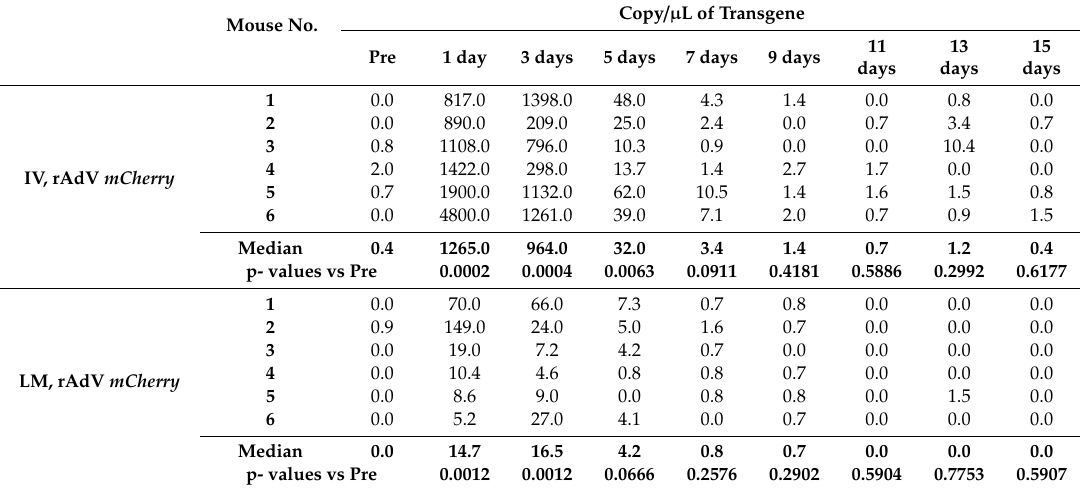
Table 5. Repeated detection of transgene fragments using ddPCR. Mouse